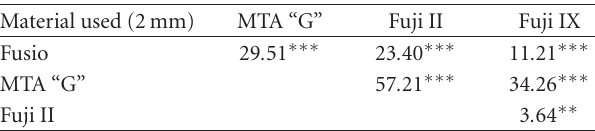
Table 3: Results of t -test for independent samples between each